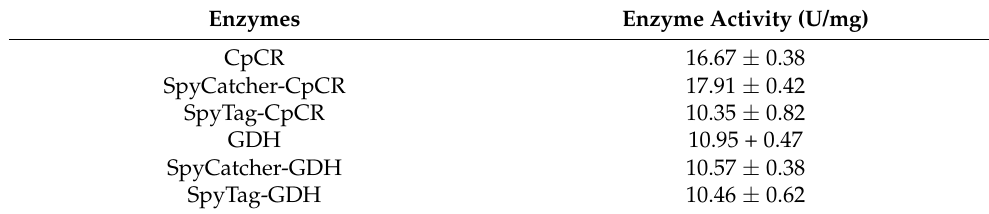
Table 5. Enzyme activity assay.